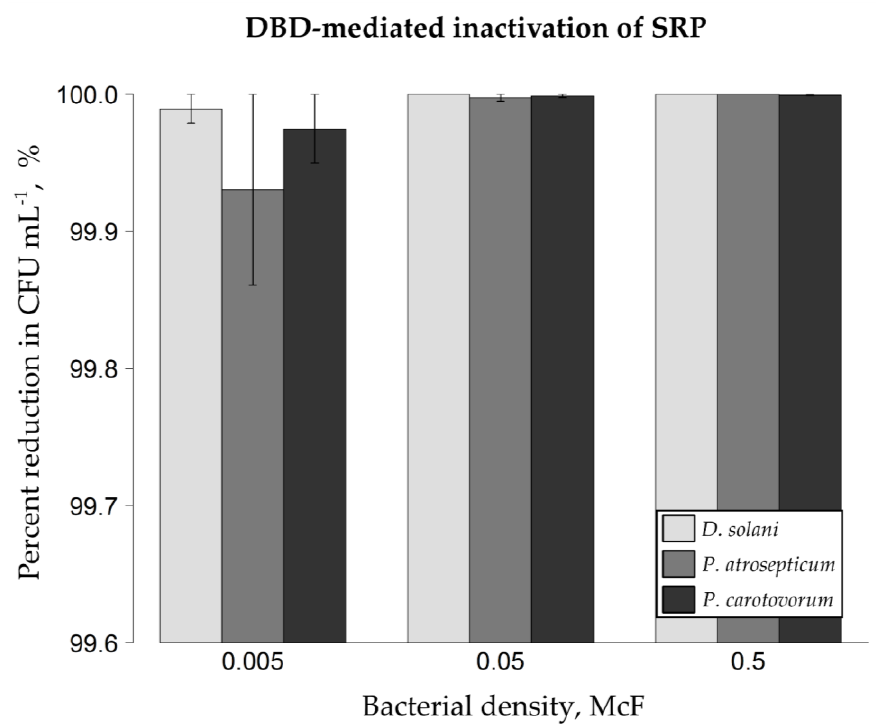
Figure 1. Inactivation efficacy of soft rot Pectobacteriaceae from glass sphere models with the use of DBD as the NTAPP source. Percentage reductions in the amount of colony-forming units (CFU) per milliliter of Ringer buffer were shown. Either 0.5, 0.05 or 0.005 McF bacterial suspension had been used for inoculating sterile model glass spheres. Means ± standard errors are depicted. The experiment was performed in triplicate with three technical replicates each. No statistically significant differences between groups were observed (Kruskal-Wallis test followed by a post-hoc analysis applying Fisher’s least significant difference criterion with Bonferroni correction at p < 0.05). D. solani IFB0099, P. atrosepticum IFB5103, and P. carotovorum IFB5118 strains were used. DBD—dielectric